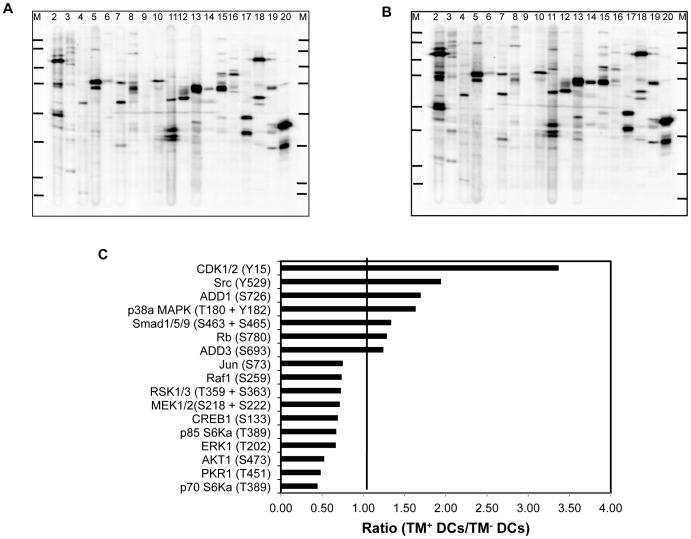
Alterations in phosphorylation of proteins in TM+ compared to TM− DCs.Cell lysates were analyzed by Western blots in which individual tracks were probed with a panel of specific anti-phosphoprotein antibodies, developed and scanned. The values from TM+ DCs were compared to those from TM− DCs as a ratio. The antibodies used are described in Table S2. The lines in lanes 1 and 21 represent the migration of the marker proteins. (A) representative Western blot of phosphoproteins from TM+ DCs. (B) representative Western blot of phosphoproteins from TM+ DCs. (C) Quantitation of Western blots showing phosphoproteins whose level had changed by >25%.